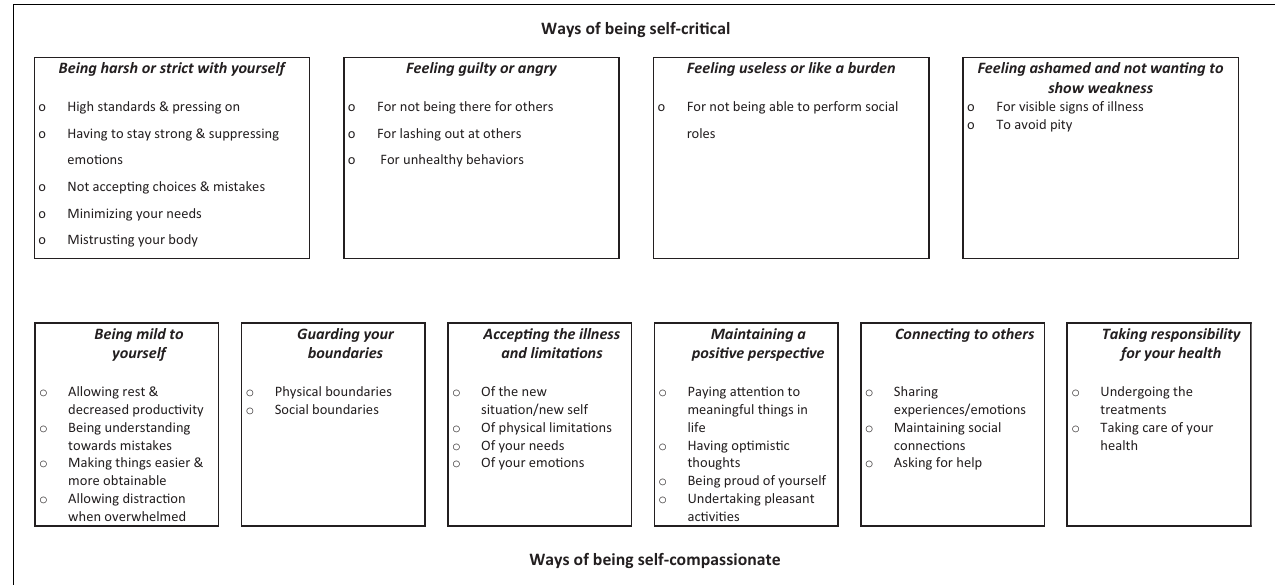
FIGURE 1 | Ways in which people with cancer are self-critical and self-compassionate in relation to their